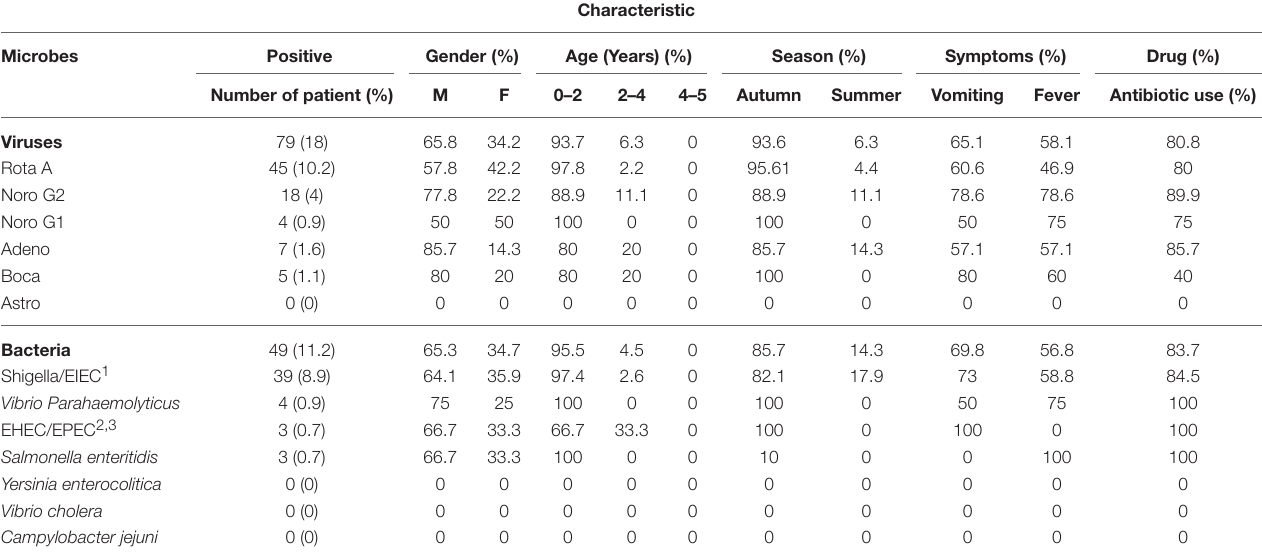
TABLE 1 | Gender, Age groups, Season, clinical characteristics and Drug by pathogens of diarrheal children. Characteristic Microbes Positive Gender (%) Age (Years) (%) Season (%) Symptoms (%)